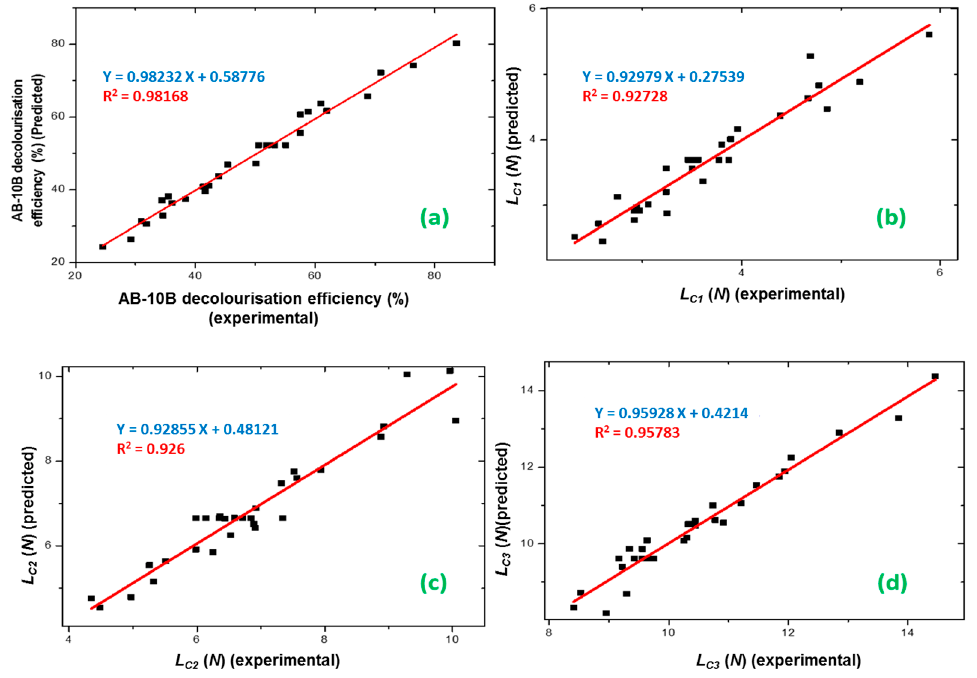
Figure 8. Graphical representations of the experimental values of ( a ) AB-10B decolorization efficiency (%), ( b ) L C1 , ( c ) L C2 , and ( d ) L C3 values plotted against the predicted values derived from the central composite design resulting equation.